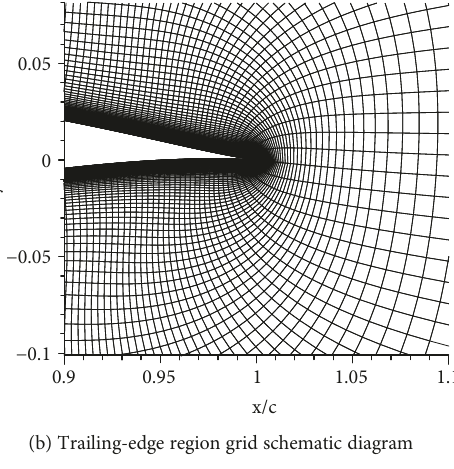
Figure 2: O-mesh for the S809